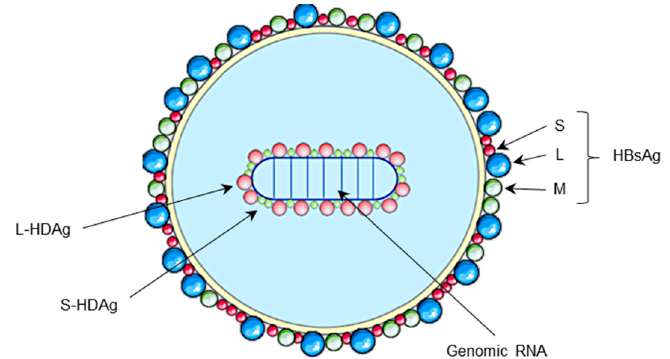
Figure 1. Hepatitis D virus (HDV) structure. (A) Schematic representation of HDV viral particle. HDV virion contains an envelope derived from the endoplasmic reticulum, in which are embedded the three forms (S, M and L) of hepatitis B virus (HBV) envelope protein, HBs antigen (HBsAg). HDV genome is a circular single stranded RNA of negative polarity associated to the two forms of delta antigen (L-HDAg and S-HDAg) forming a ribonucleoproteic complex.